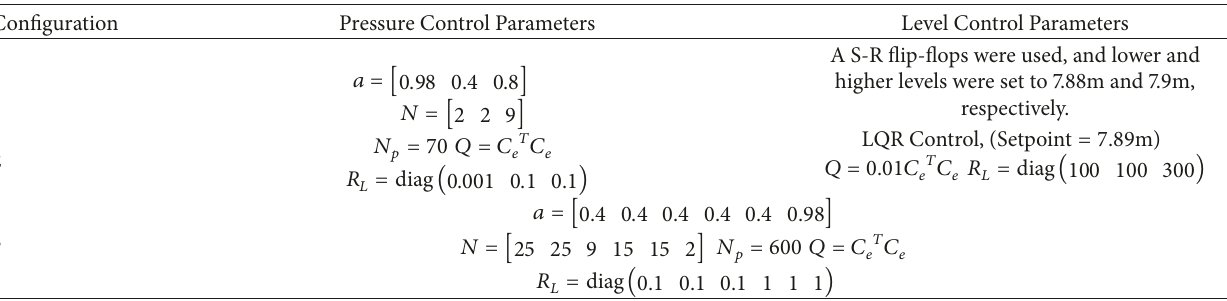
Table 3: Pressure and level control